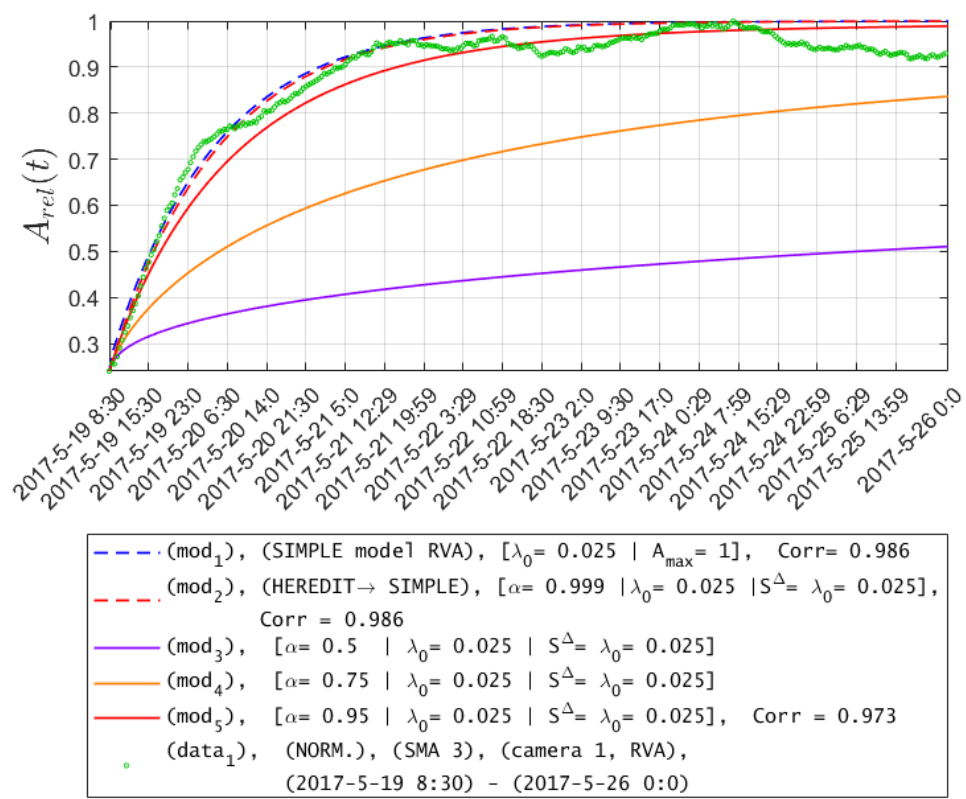
Figure 8. Data on the accumulations of radon in the chamber on YSSR (green circle) and model curves with different